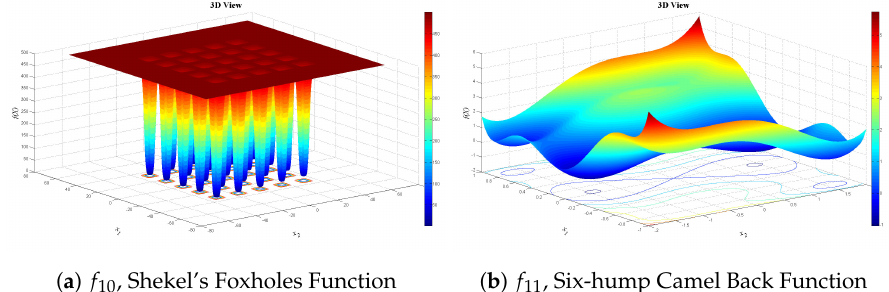
Figure 8. Multimodal functions with fixed dimensions f 10 and f 11 in a 3D view.